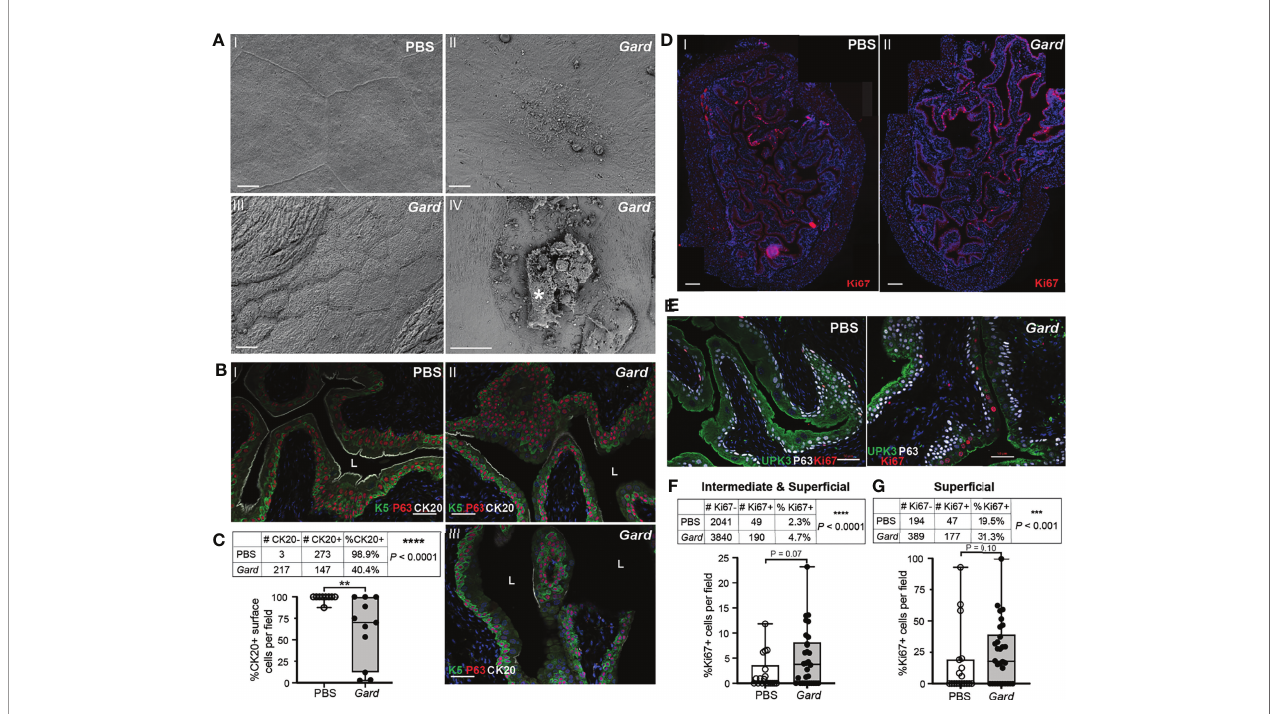
FIGURE 3 | Gardnerella exposures result in urothelial exfoliation and proliferation. (A) Scanning electron micrographs of bladders collected 12 h after two exposures (the model used for RNA-seq, see Figure 1 schematic) to PBS (panel I) or Gardnerella (II – IV). (I) Intact super fi cial umbrella cells; (II) umbrella cell with membrane blebbing; (III) region of exfoliation with smaller underlying intermediate cells visible at the luminal interface; (IV) exfoliating umbrella cell marked by an asterisk. Scale bars = 10 m m. (B) Immuno fl uorescence microscopy of urothelial differentiation markers in bladder sections from mice exposed to PBS (I) or Gardnerella (II and III). Keratin 5 (K5) in green labels, basal cells; P63 in red labels, basal and intermediate cells; and cytokeratin 20 (CK20) in white labels, the apical surface offully differentiated umbrella cells. Scale bars = 50 m m. (C) Counts of CK20-positive (+) and CK20-negative ( − ) cells on the urothelial surface, adjacent to the lumen. **** p < 0.001, Fisher ’ s exact test. The graph was generated by plotting the %CK20 positivity, with each dot representing an individual microscopy image of the ×20 fi eld of view. ** p < 0.01, Mann – Whitney U test. Box plot denotes the 25th and 75th percentiles with a line at the median and whiskers from min to max. (D) Panoramic assembly of bladder sections stained for Ki67 in red. Scale bars = 200 m m. (E) Representative images of immuno fl uorescence microscopy used for Ki67+ enumeration. (F, G) Tables show the counts of Ki67-positive (+) and Ki67-negative ( − ) cells of super fi cial and intermediate cells combined (F) or only super fi cial cells (G) in each experimental group. *** p < 0.001, **** p < 0.0001, Fisher ’ s exact test. Graphs were generated by plotting the %Ki67 positivity, with each dot representing an individual microscopy image as in (B) . Box plot denotes the 25th and 75th percentiles with a line at the median and whiskers from min to